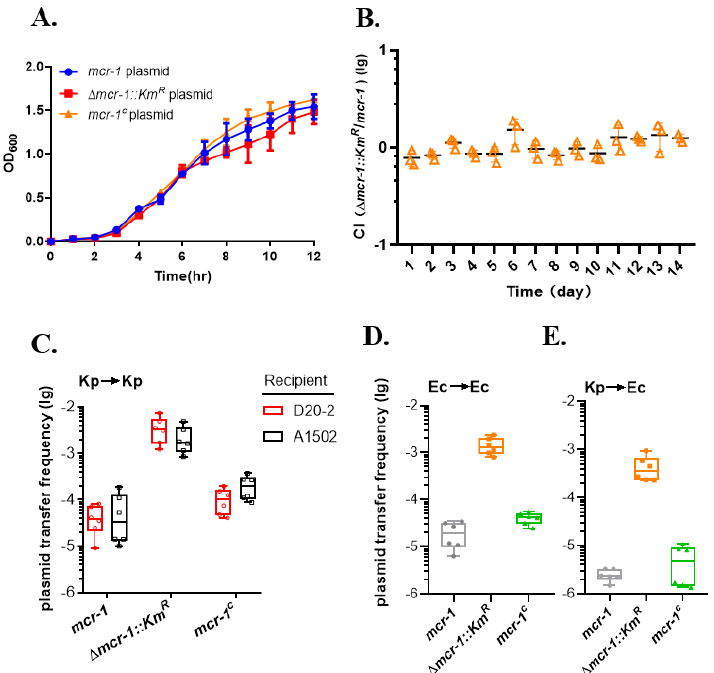
Figure 2. mcr-1 effect on conjugal transfer of pHNSHP45 plasmid. ( A ) Growth curve of K. pneumoniae A2312NM carrying different plasmids. ( B ) Growth competition assay between K. pneumoniae A2312NM harboring mcr-1 plasmid or ∆ mcr-1::Km R plasmid. Samples were transferred to fresh LB medium every day, and CFU was calculated with appropriate antibiotic. Transfer frequency of mcr-1 plasmid between different strains, including K. pneumoniae A2312NM to K. pneumoniae D20-2 (red) or A1502 (black) ( C ), E. coli MG1655 to E. coli Nissle 1917 ( D ), and K. pneumoniae A2312NM to E. coli MP13 ( E ). An equal volume of donor strain harboring the mcr-1 plasmid, ∆ mcr-1::Km R plasmid or mcr-1 c plasmid, and recipient strain were mixed and concentrated 50-fold. Conjugation was performed for 4 h at 37 °C.